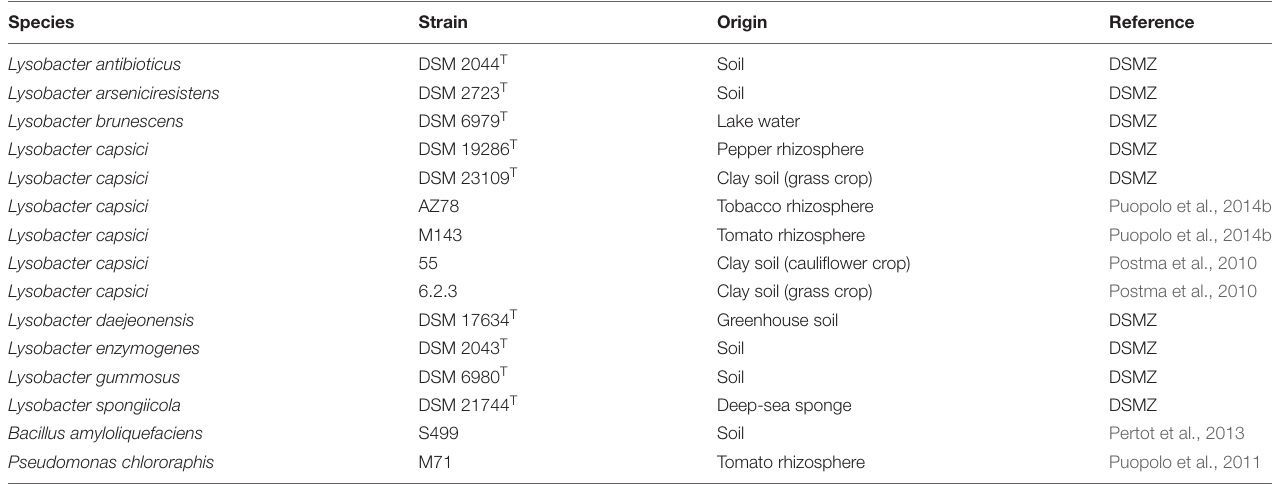
TABLE 1 | Bacterial